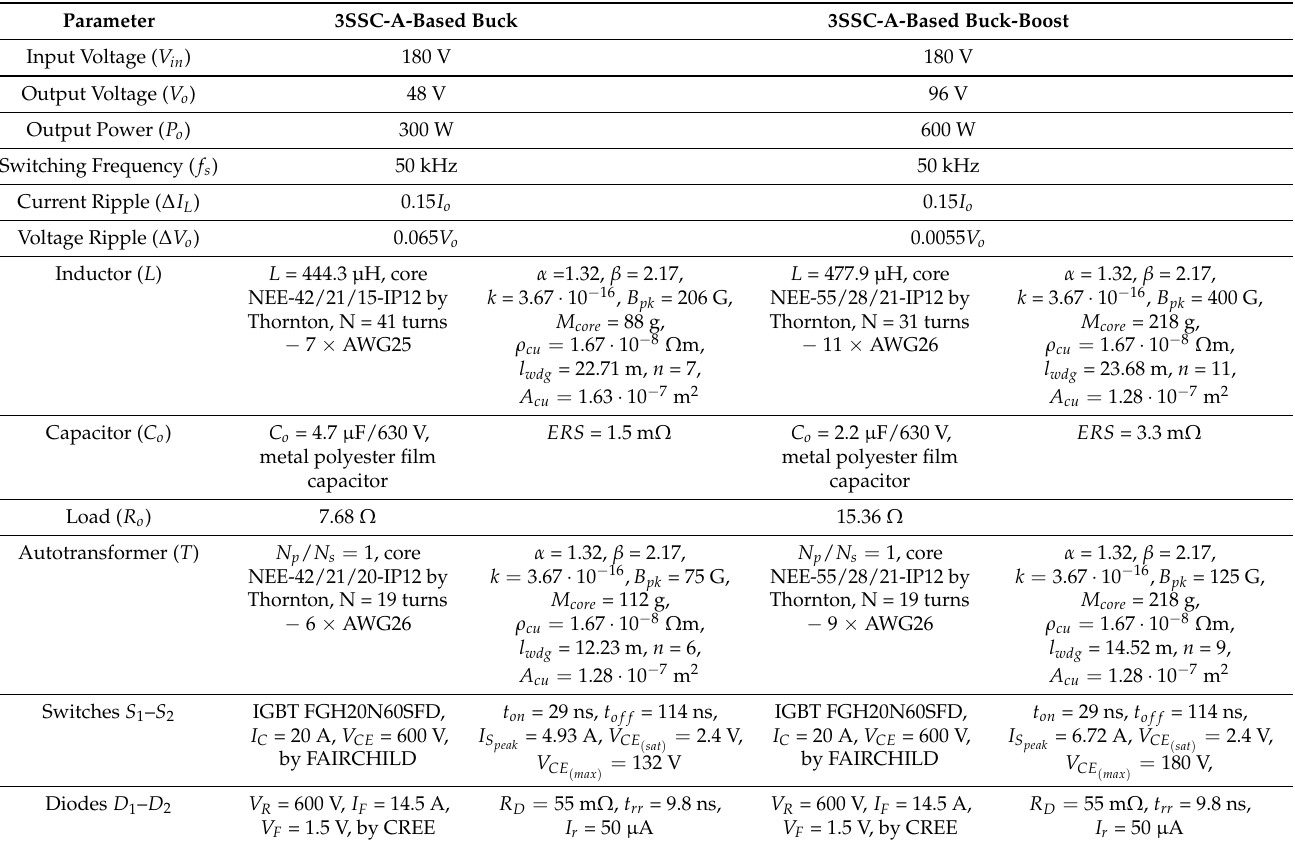
Figure 8. Frequency analysis of 3SSC-A-based buck-boost converter: ( a ) Validation of transfer function G vd ( s ) ; ( b ) Open-loop transfer-function. Table 5. Design